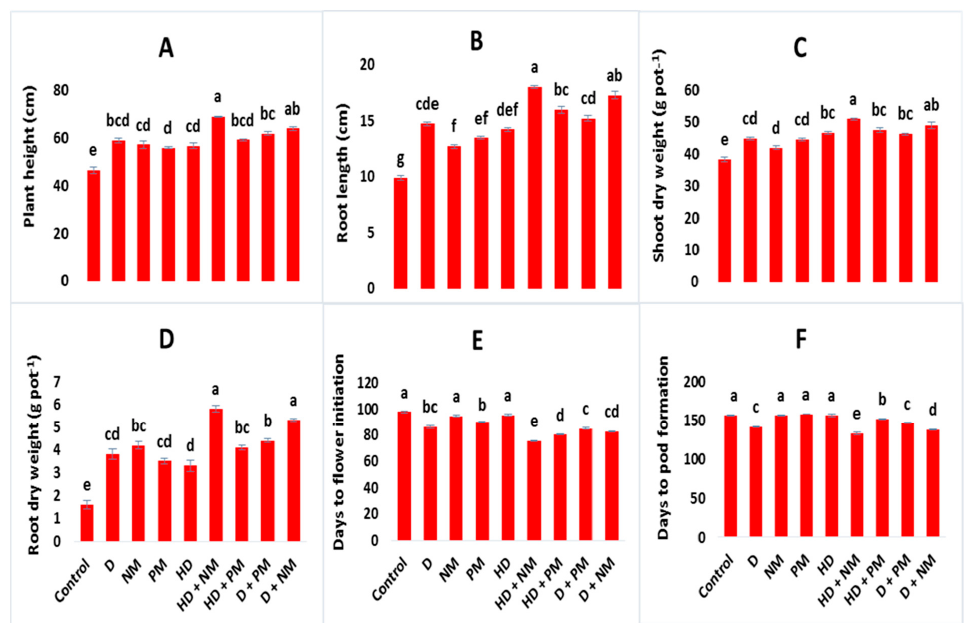
Figure 1. Effect of animal manures with DAP fertilizer on plant growth and root–shoot biomass of chickpea ( A ) plant height, ( B ) root length, ( C ) shoot dry weight, ( D ) root dry weight, ( E ) days to flower initiation and ( F ) days to pod formation of chickpea D: Recommended DAP; NM: Normal manure; PM: Processed manure; HD: Half of the recommended dose of DAP. Figure bars are showing the mean values ( n = 3). All means followed by different letters have statistically significant differences according to Tukey’s HSD test at probability level of 0.05.